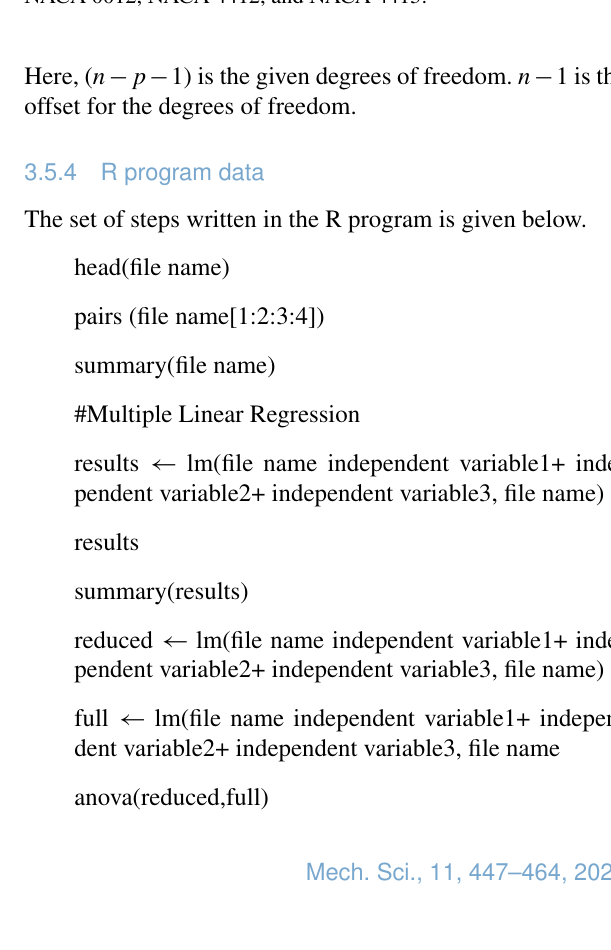
Figure 9. Star glyph showing static pressure for three airfoils, NACA 0012, NACA 4412, and NACA